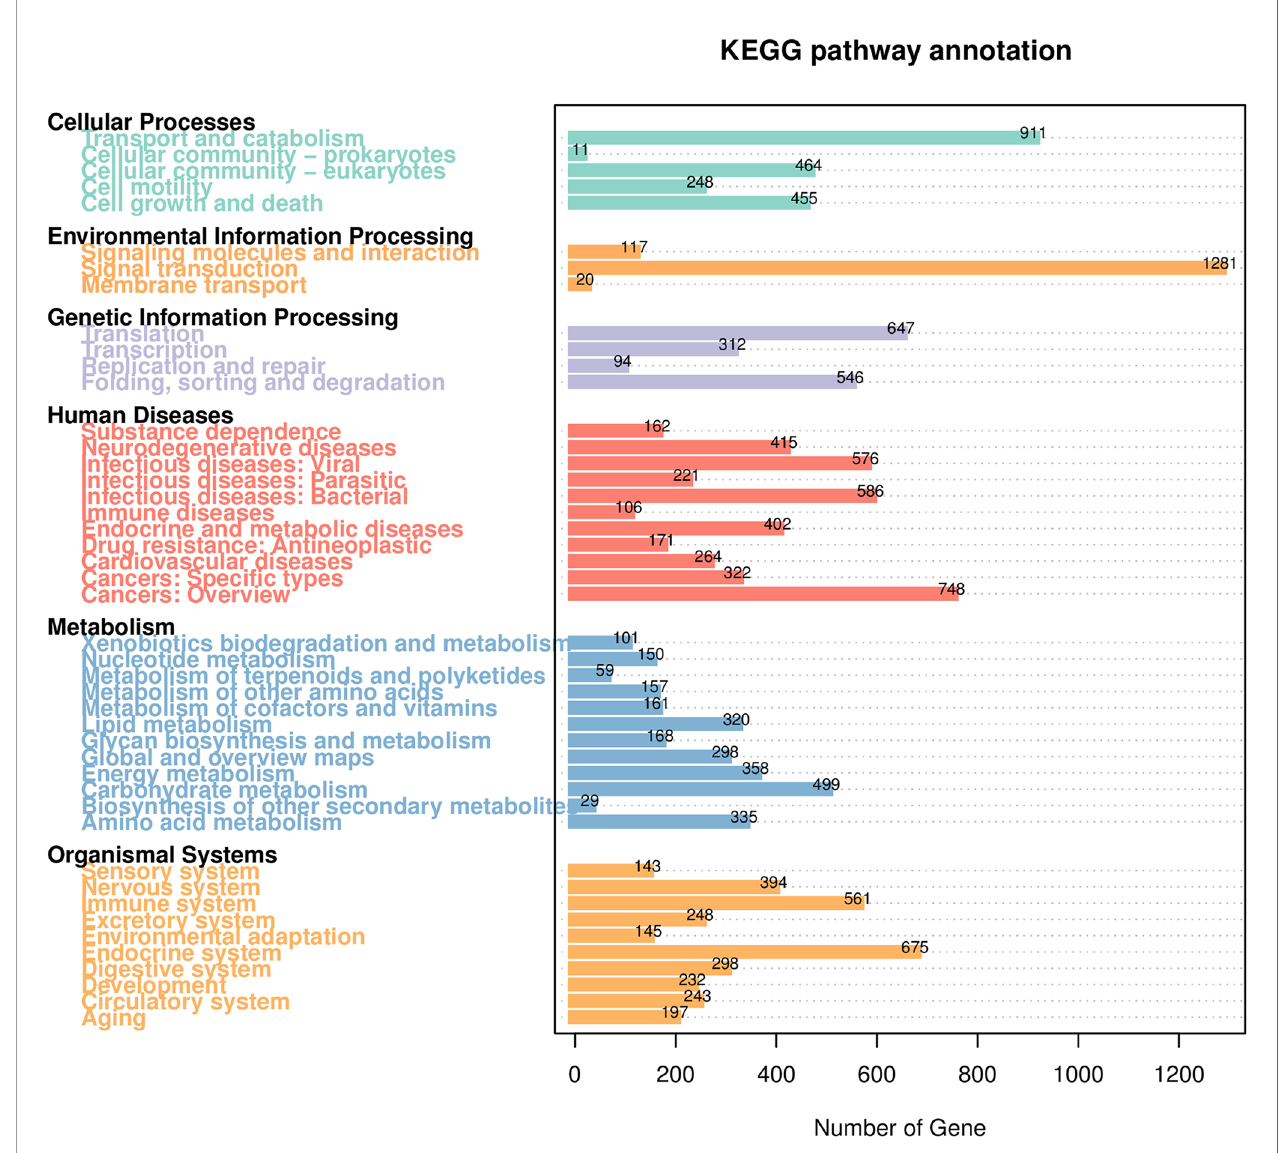
FIGURE 2 | KEGG pathway classi fi cation of the transcripts. The number above the bars indicates the number of transcripts annotated in different KEGG